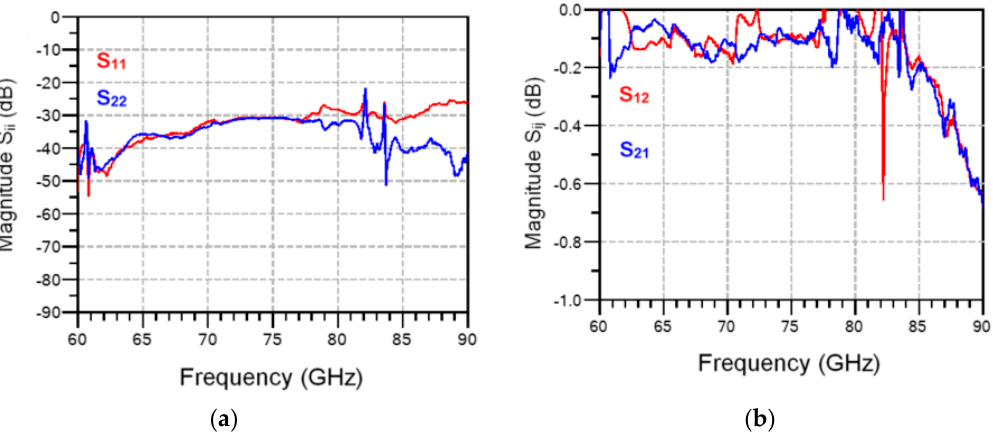
Figure 28. Calibration kit line (L) measurements, second landing after 5 h of measurements: ( a ) matching; ( b ) insertion loss.